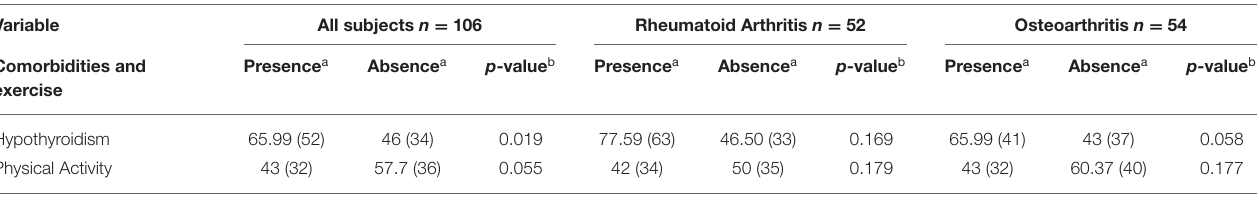
TABLE 4 | Vascular age values based on different